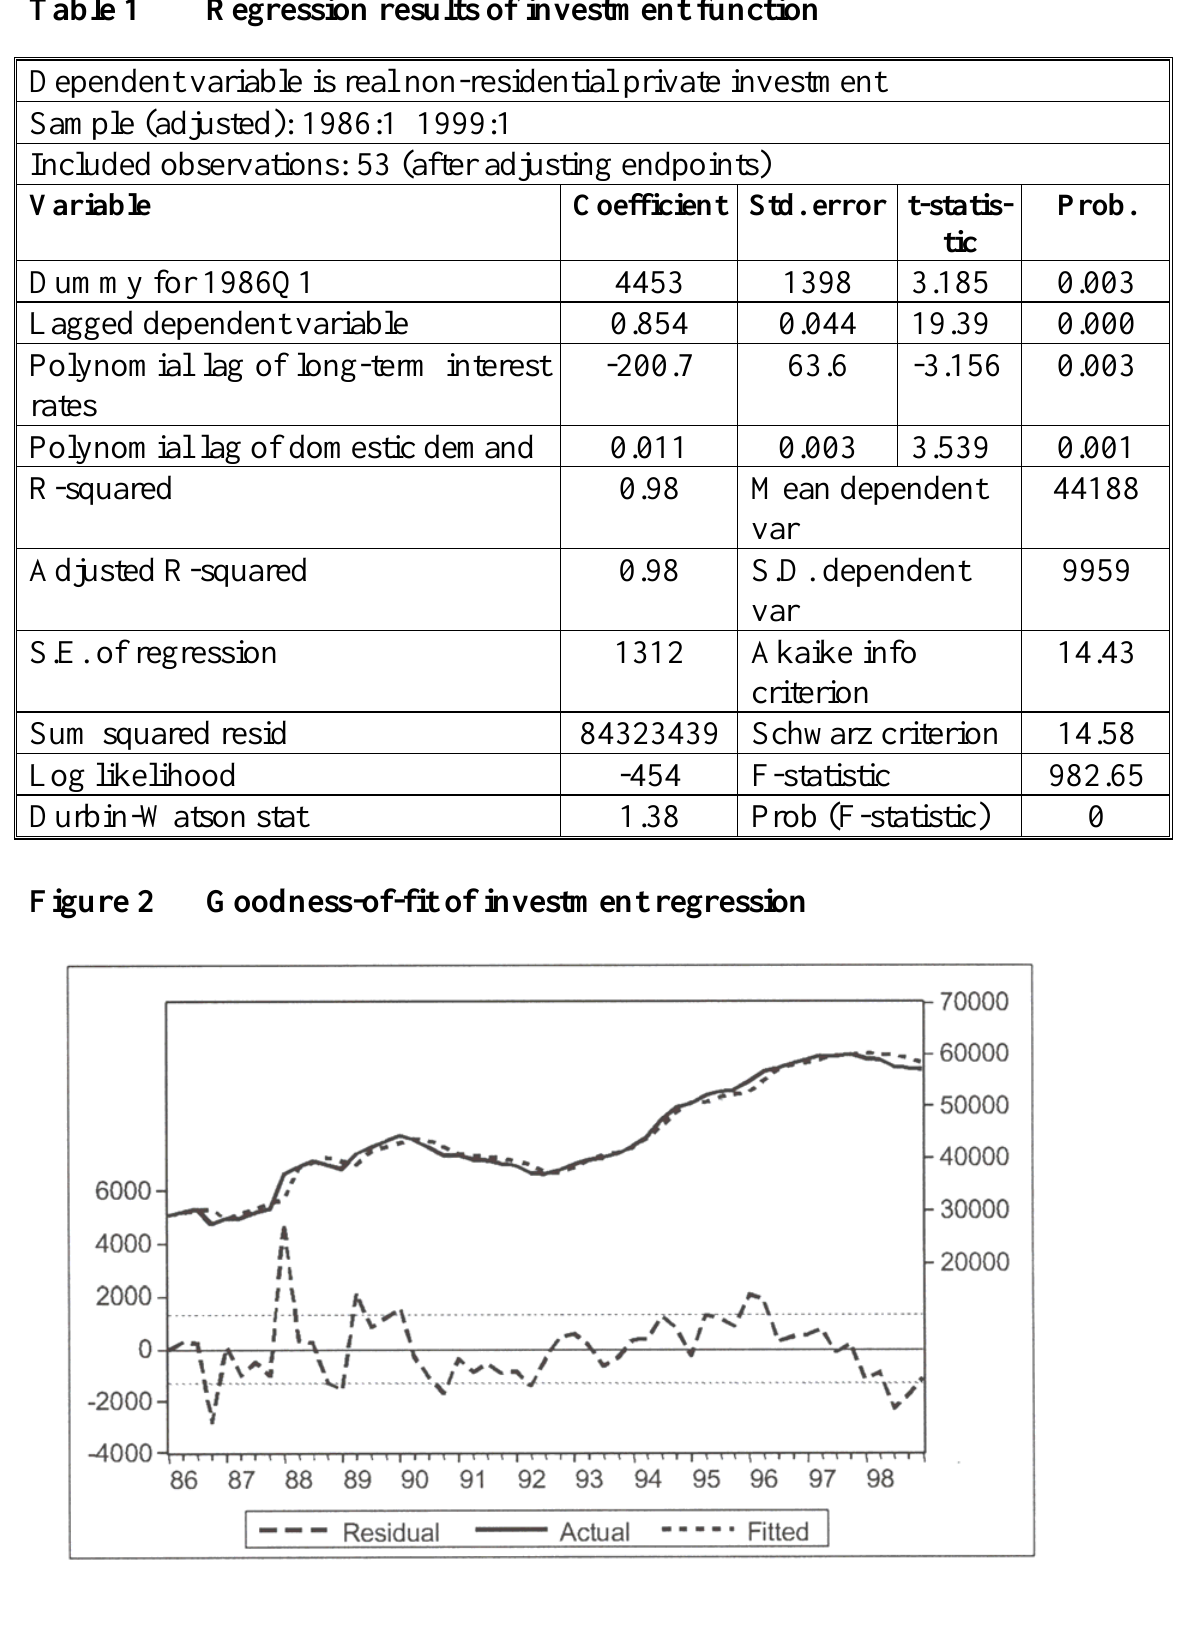
Regression results of investment function